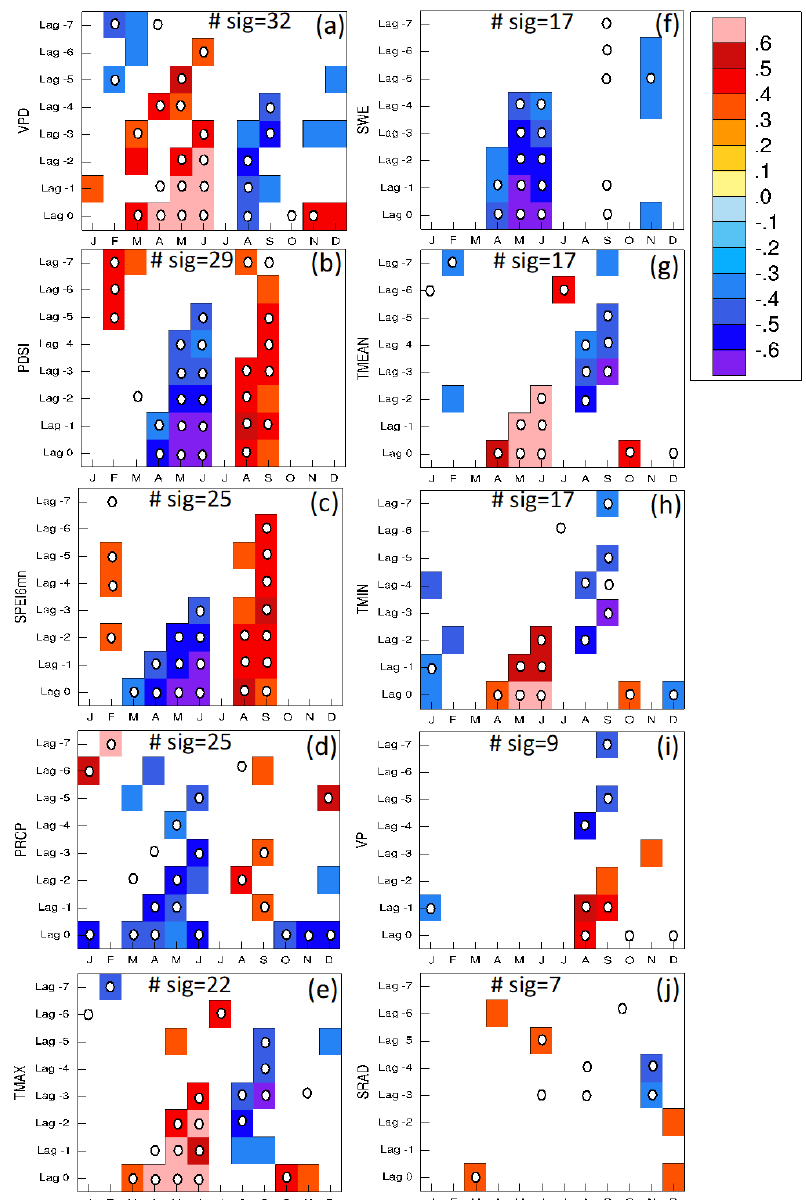
Figure 8. Pearson’s temporal correlations between detrended monthly Advanced Very High-Resolution Radiometer (AVHRR) Normalized Difference Vegetation Index (NDVI) anomalies, averaged across Yellowstone National Park, and park-mean antecedent atmospheric detrended monthly anomalies (leading NDVI by 0 to 7 months) from Daymet and Western Regional Climate Center (WRCC) during 1982 – 2015. Only statistically significant correlations ( p < 0.05) are displayed. Correlations are shown for ( a ) vapor pressure deficit, ( b ) Palmer Drought Severity Index (PDSI), ( c ) 6-month Standardized Precipitation Evapotranspiration Index (SPEI), ( d ) precipitation, ( e ) maximum daily temperature, ( f ) snow – water equivalent, ( g ) mean temperature, ( h ) minimum daily temperature, ( i ) vapor pressure, and ( j ) incoming surface shortwave radiation. For each panel, the number of significant correlation boxes (out of 96) is provided. For example, in column 5 of panel ( f ), the park’s average NDVI anomalies in May exhibit a statistically significant negative correlation with snow–water equivalent from the preceding to concurrent period of January–May (as shown by the blue/purple boxes under lag 0 to lag − 4). Dots indicate significant Spearman’s rho ( p < 0.05) as a further test of robustness, beyond the Pearson’s correlations. The number of significant boxes for the Spearman’s rho is 25, 27, 24, 22, 20, 18, 17, 16, 9, and 8 for ( a ) through ( j )